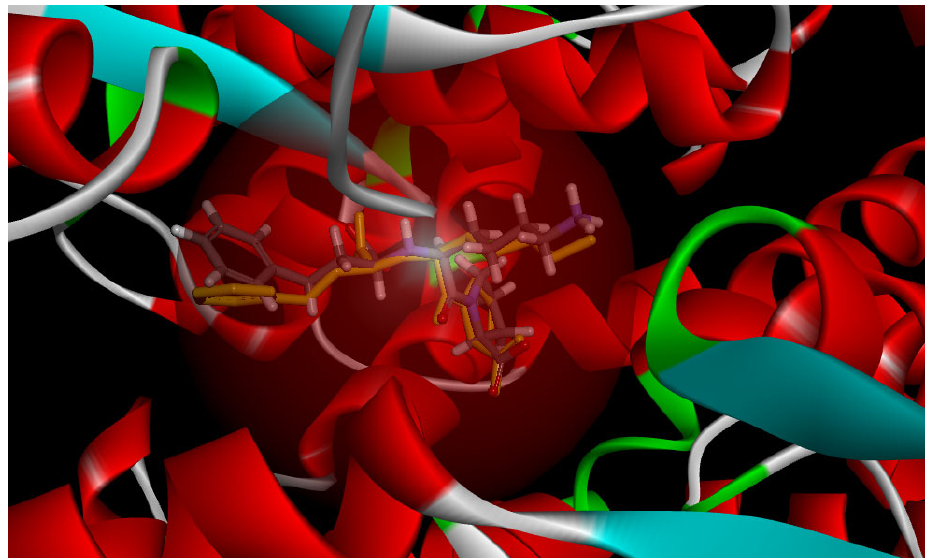
Figure A6. The interaction of lisinopril and tACE (1O86.pdb). The ribbon demonstrates tACE. The substantial overlapping of lisinopril was achieved via docking (yellow color) and the enzyme derived from PBD (1O86) proved the accuracy of the current model. The docking energy score between lisinopril and tACE is − 92.8494 kJ/mol (CDocker).